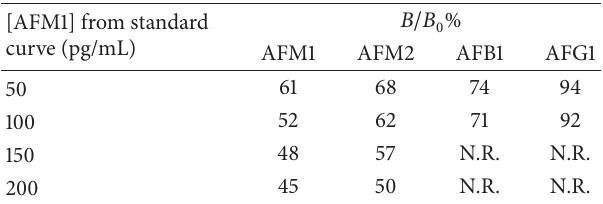
Table 3: Summary of 𝐵/𝐵 0 % of various aflatoxins using standard curve of